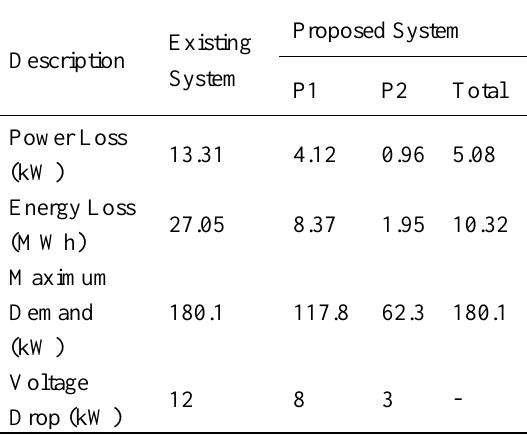
Losses estimation of existing system and proposed